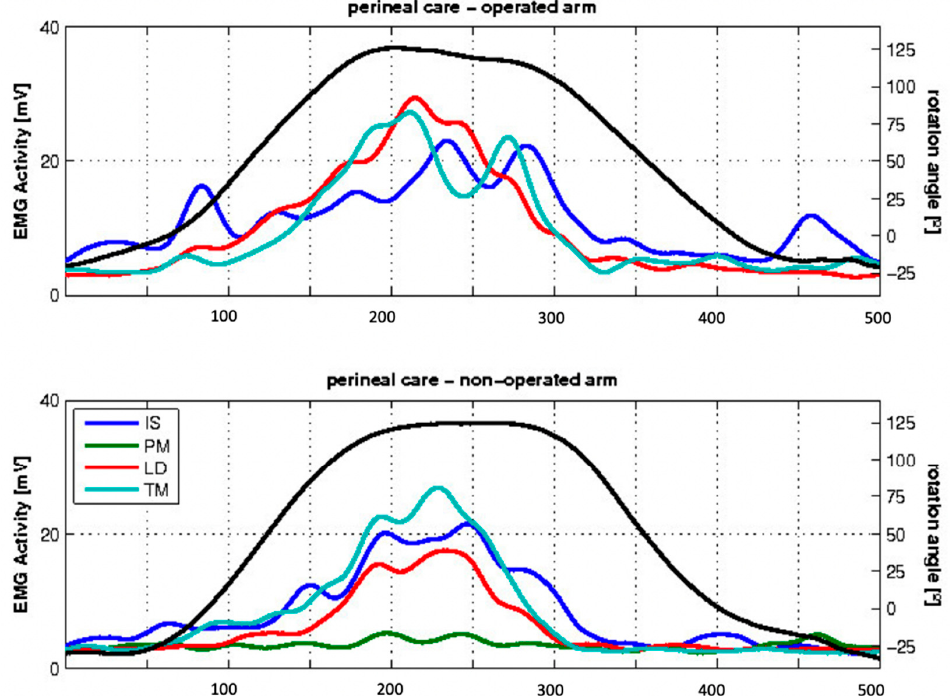
Figure 6. Mean EMG activity of the examined patients during the ADL of perineal care. The x-axis indicates the frames, and the y-axis indicates, on the left side, the EMG activity in mV of the di ff erent muscles (colored lines) and, on the right side, the angle of rotation represented by the black line. Negative values show exo-rotation, and positive values endorotation.